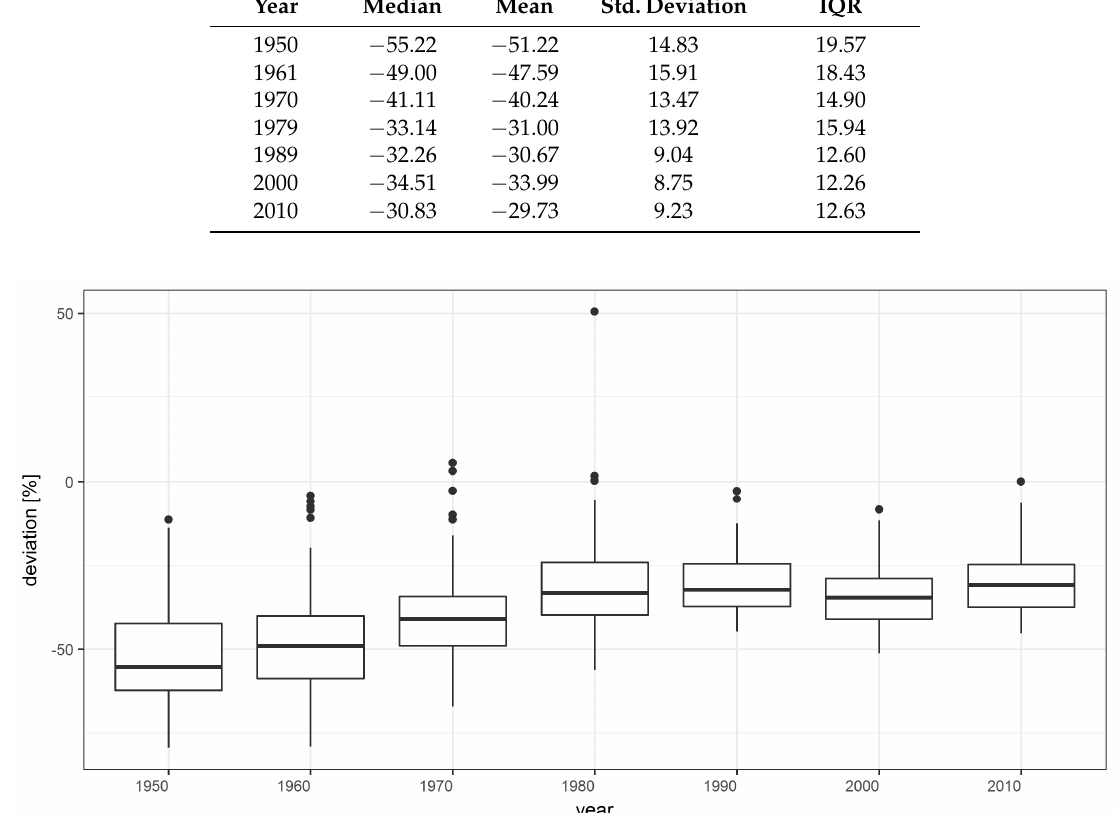
Figure 9. Distribution of relative errors for time steps.